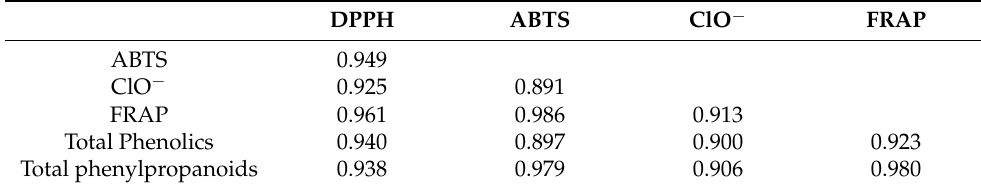
Table 5. Pearson correlation coefficients (r) between parameters describing the contents of total phenolics and phenylpropanoids and different antioxidant activities of the methanolic standardized extracts of Cirsium species and Cirsii Herb. DPPH ABTS ClO − FRAP ABTS 0.949 ClO − 0.925 0.891 FRAP 0.961